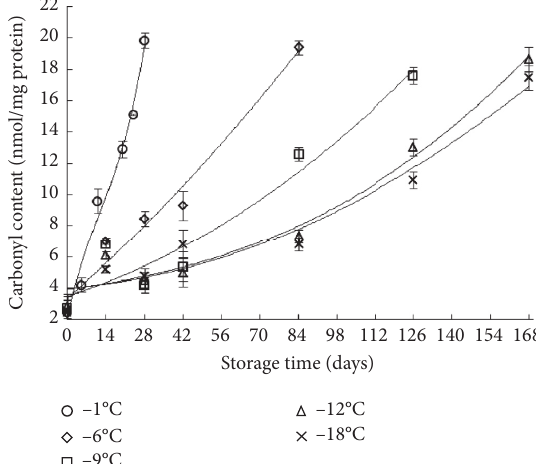
Figure 1: Changes in the sulfhydryl content of beef MP during storage at − 1, − 6, − 9, − 12, and − 18 ° C.